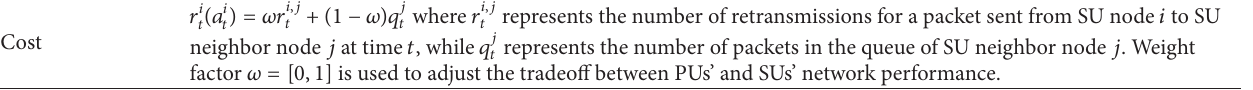
Table 2: Reward representation for WCRQ-routing model embedded at SU node 𝑖 .